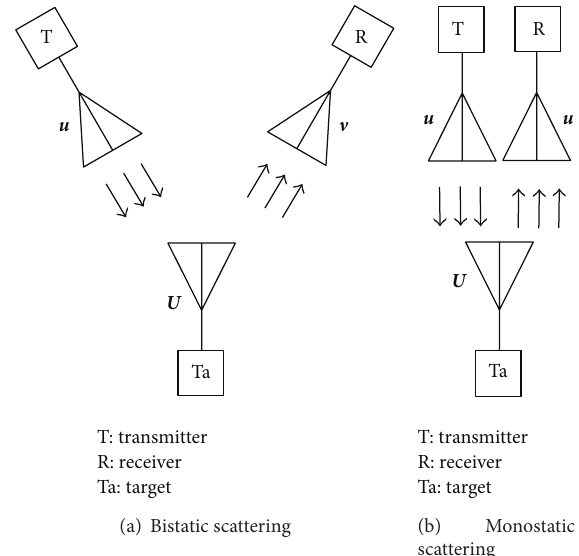
Figure 1: Antenna scattering configuration.